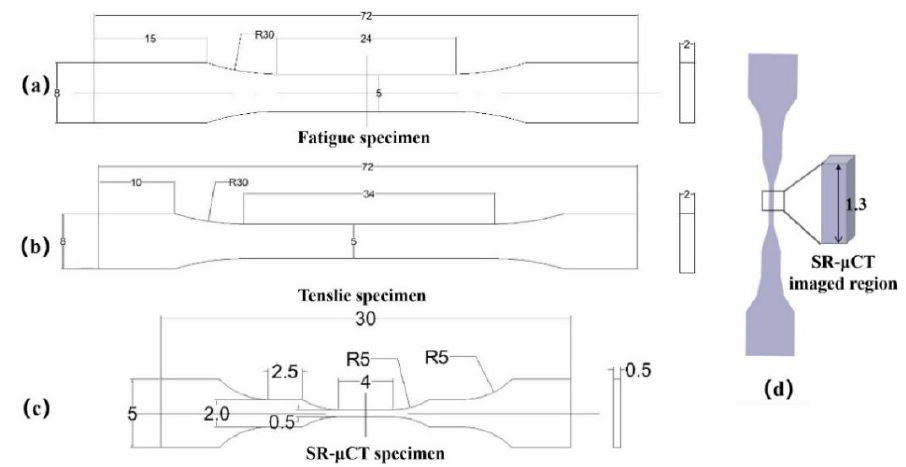
Figure 1. Specimen size: ( a ) fatigue specimen, ( b ) tensile specimen, ( c ) SR- μ CT specimen, ( d ) synchrotron radiation imaging region (dimensions in mm). Table 2. Test, test equipment, and test methods.